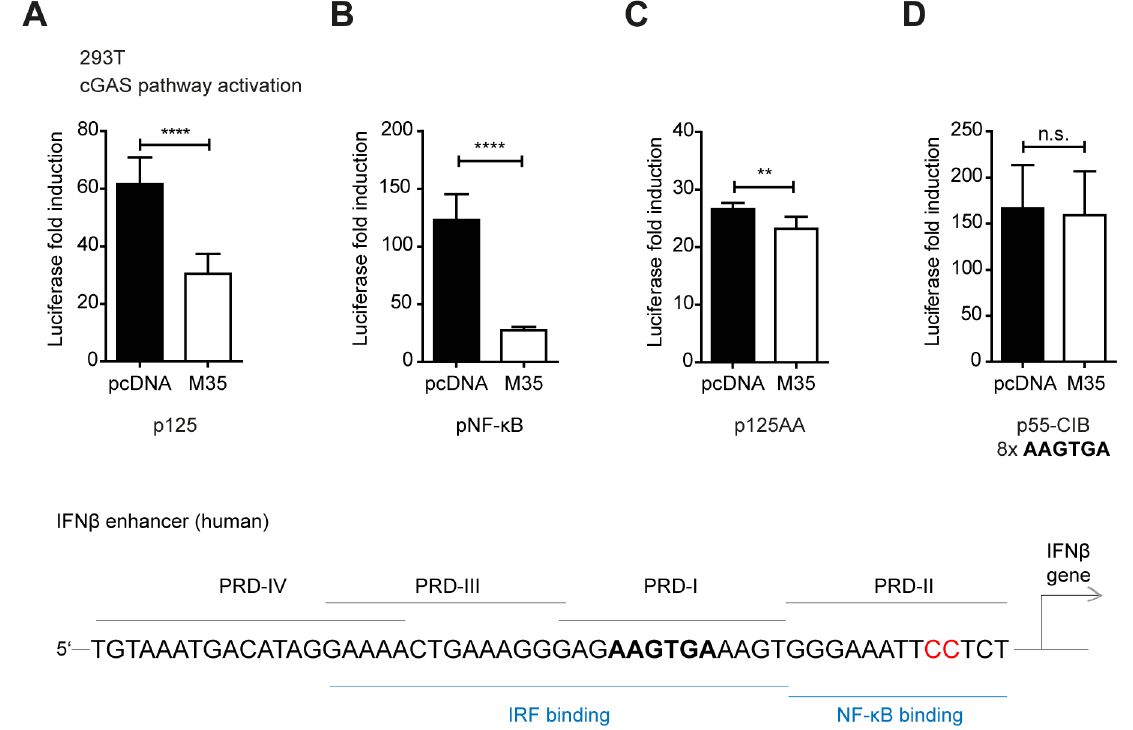
Fig 5. M35 targets NF- κ B-but not IRF-mediated transcription. (A) 293T cells were co-transfected with expressionplasmids for either cGAS (stimulated) or GFP (unstimulated) togetherwith mCherry-STING, the p125 and pRL-TK luciferase